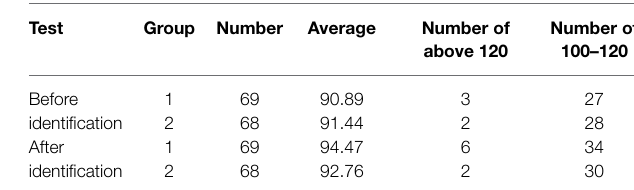
TABLE 4 | Comparison of student achievement changes before and after